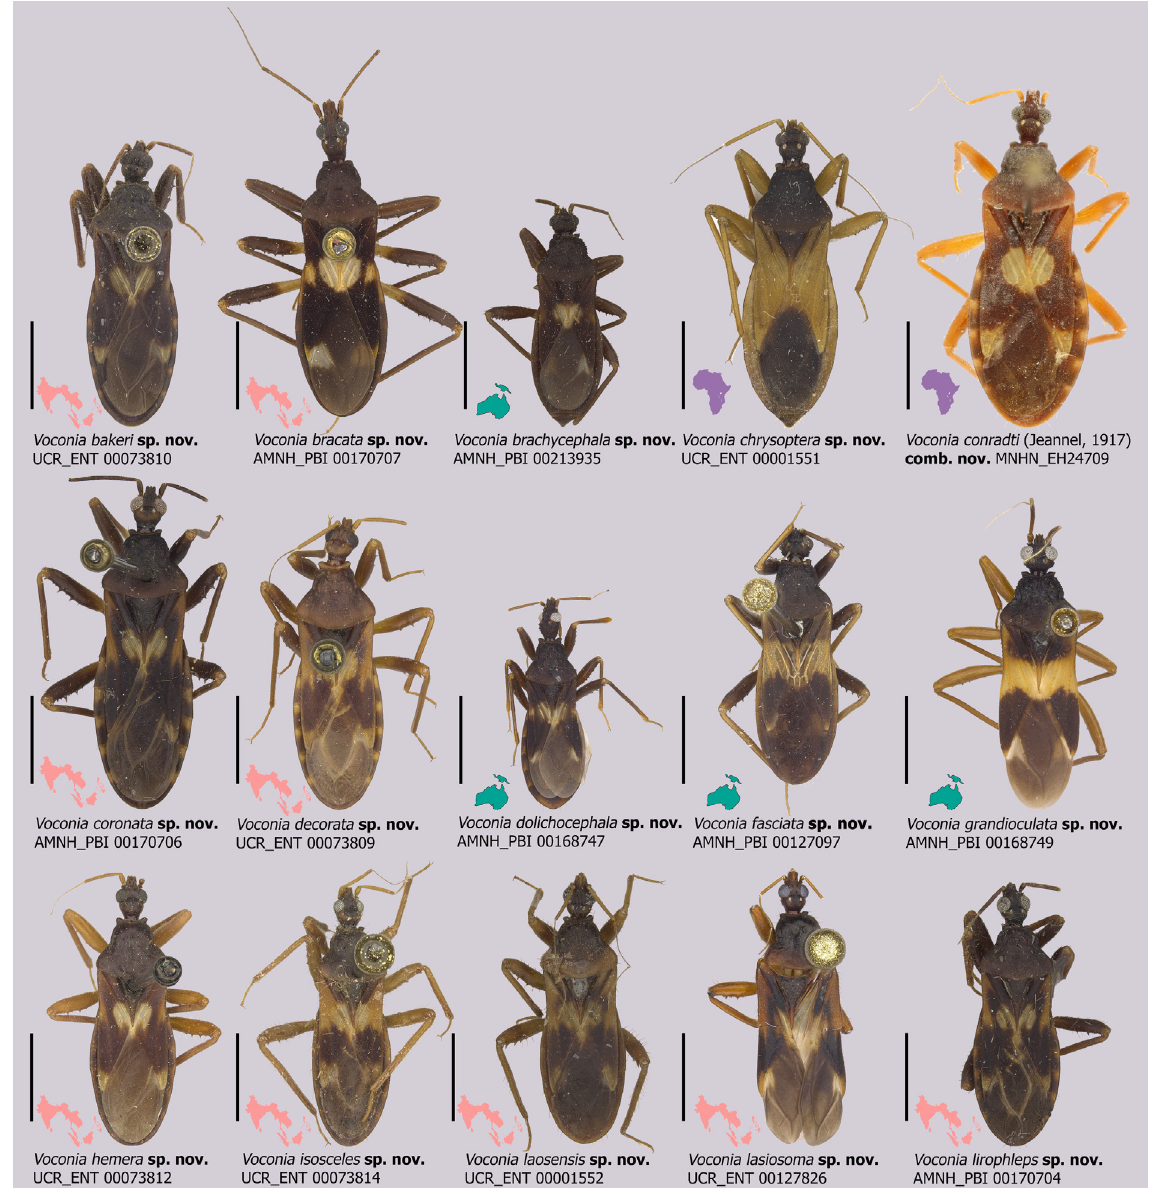
Fig. 7. Dorsal habitus of holotypes of Voconia Stål, 1866 species with distribution: purple = Afrotropical region, green = Australasian region, pink = Oriental region. Scale bars = 3